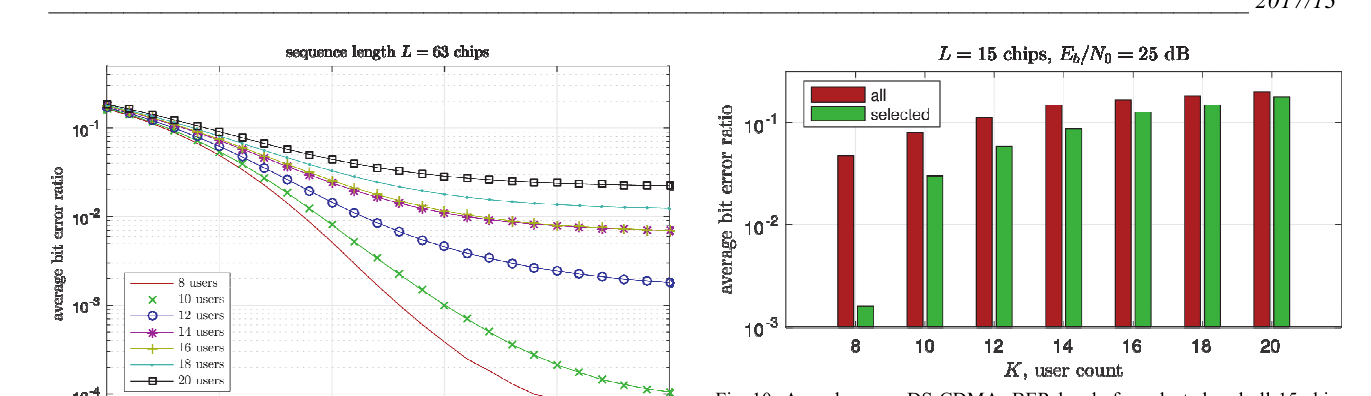
Fig. 10. Asynchronous DS-CDMA: BER levels for selected and all 15-chip- long sequences generated by logistic map at SNR per bit at a level of 25 dB.